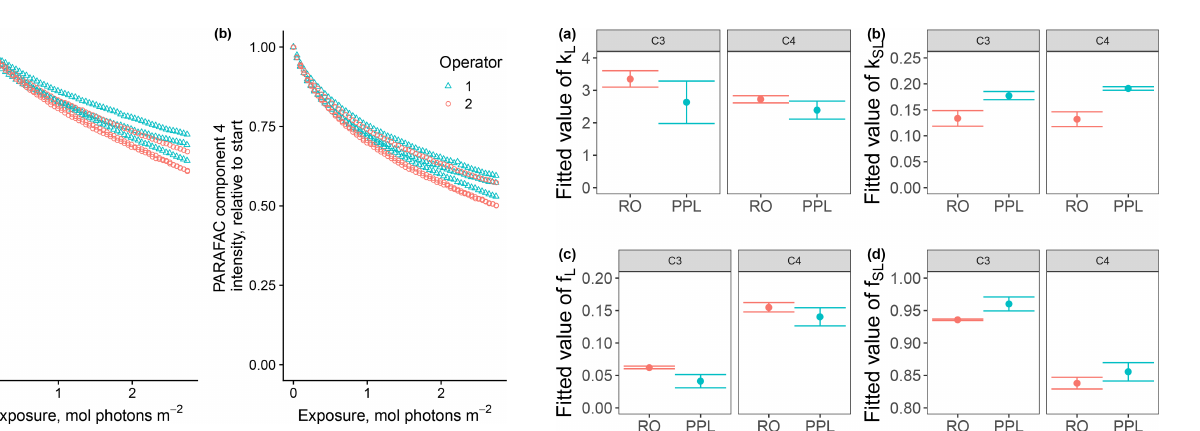
Figure 5. Photodegradation time series of PARAFAC compo- nents three (a) and four (b) fluorescence intensity, relative to start- ing values. Data are shown from experiments using SRNOM PPL performed by two of the authors to test reproducibility of results.